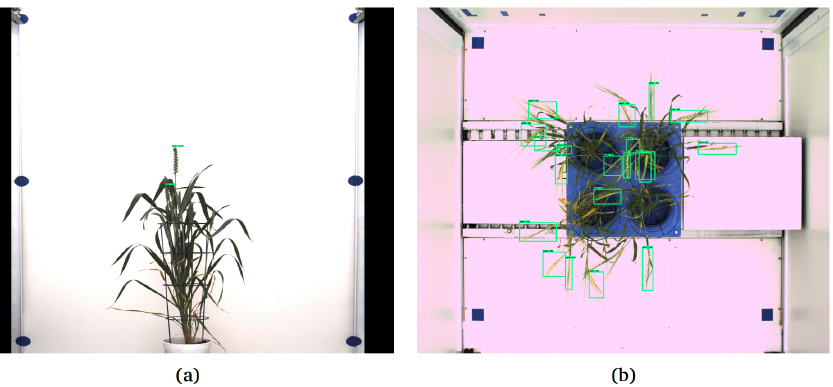
Figure 8. Examples of application of Faster-RCNN trained on data set in Table 2 for the detection of spikes of Central European wheat cultivars in images with different (white) background: ( a ) DNN failed to detect some spikes in the side view image, ( b ) early emergent spikes and some matured spike in the top view remained